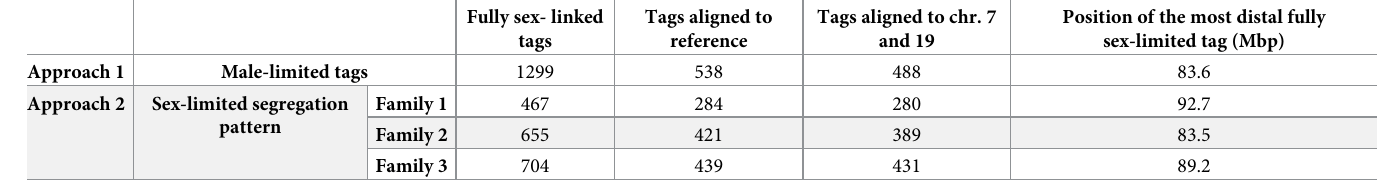
Table 1. Fully sex-linked RADtag counts. The positions of the most distal fully sex-linked tags are based on their map position relative to chromosome 7 of the M . mus- culus domesticus reference genome (Mbp: megabase